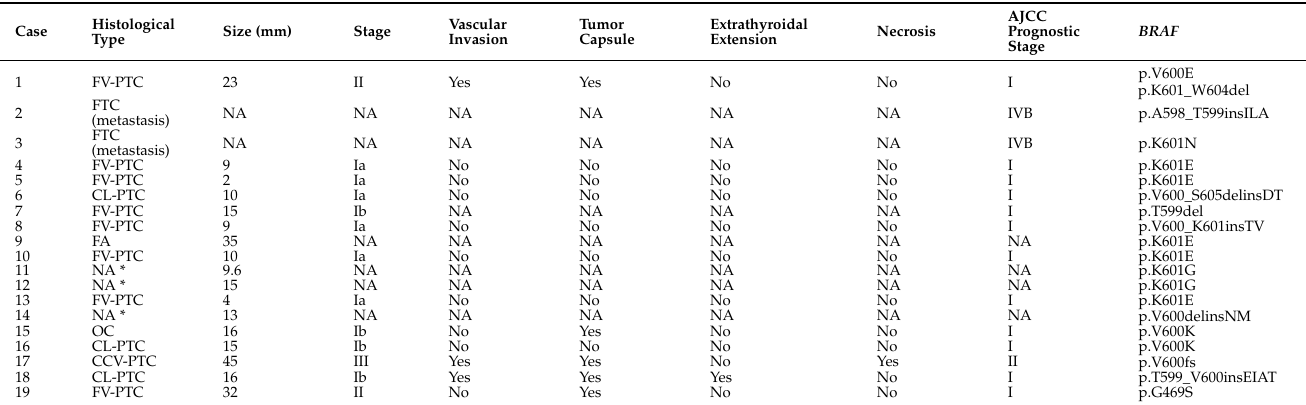
Table 4. Description of the clinicopathological characteristics of the 19 cases harboring BRAF non- V600E alterations.